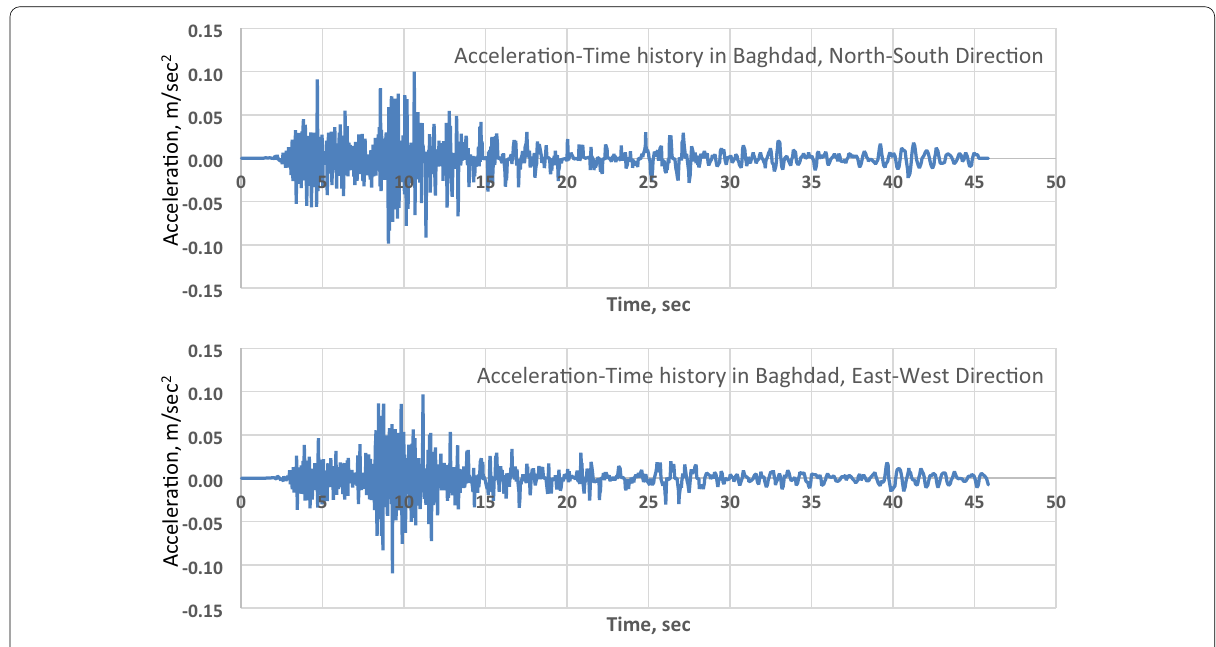
Fig. 6 Scaled acceleration–time history of Halabjah earthquakes.